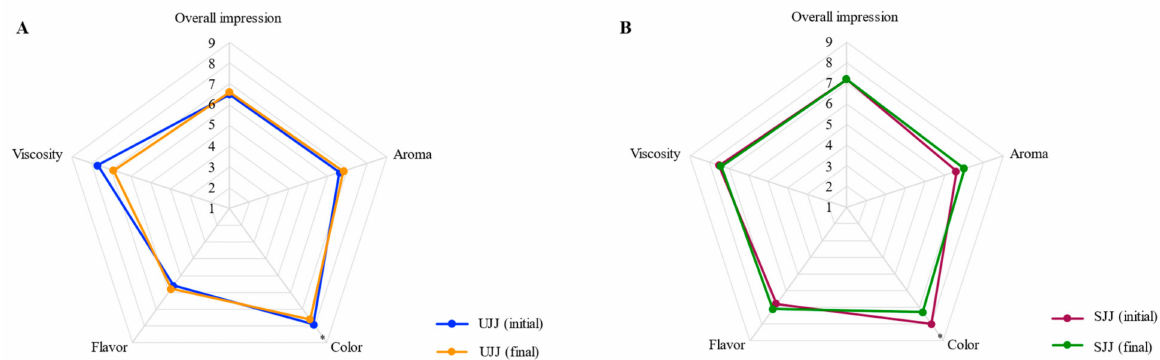
Figure 3. Average scores of descriptive sensory analysis of unsweetened ( A ) and sweetened ( B ) jaboticaba juices, UJJ and SJJ, respectively. Asterisks indicate means significantly different (Mann–Whitney unpaired test; p < 0.05). Nine-point scale: 1 = dislike extremely; 2 = dislike very much; 3 = dislike moderately; 4 = dislike slightly; 5 = neither like nor dislike; 6 = like slightly; 7 = like moderately; 8 = like very much; 9 = like